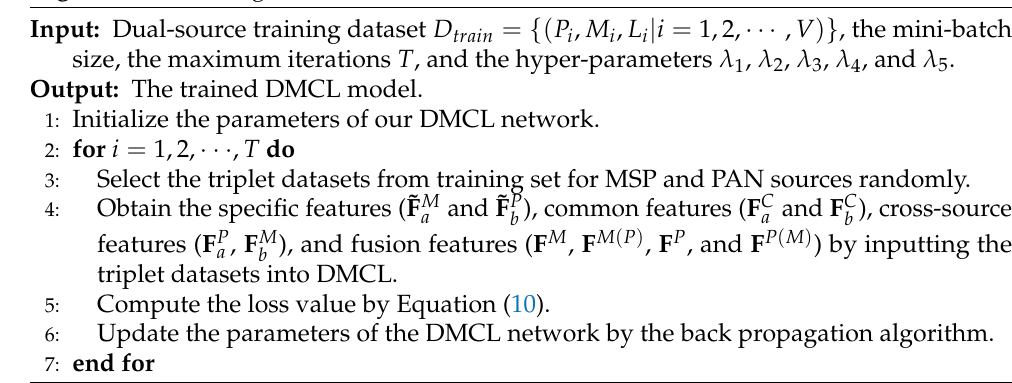
Algorithm 1 Training Process of DMCL.